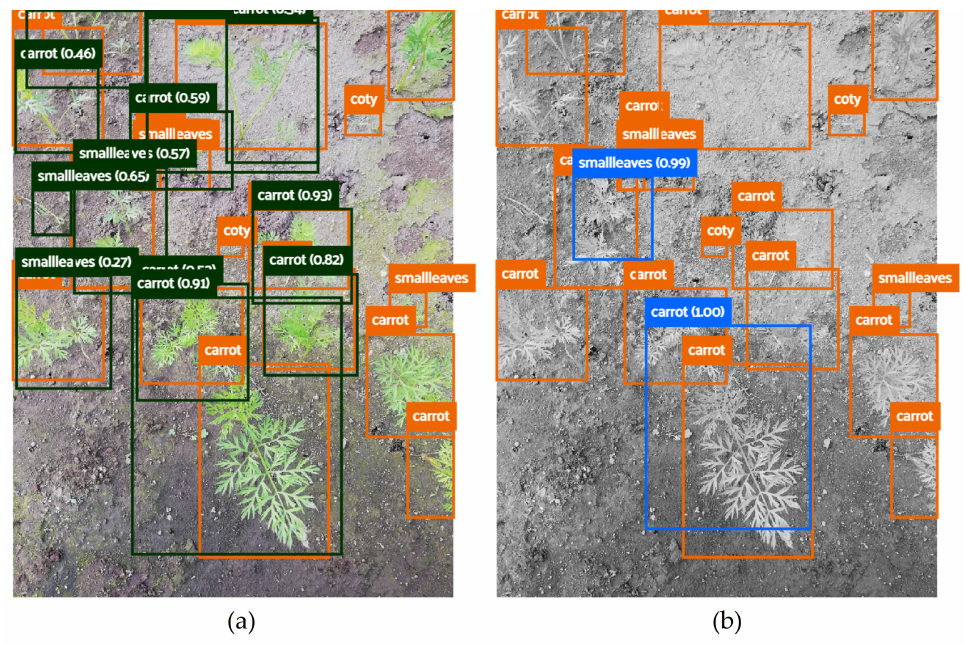
Figure 4. Carrot phenophase predictions made by SSD MobileNet v2 (300 × 300 px) using RGB ( a ) and the corresponding greyscale ( b ) image. Carrot phenophases are described as: coty (opened cotyledons), smallleaves (one to three unfolded leaves), and carrot (more than three unfolded